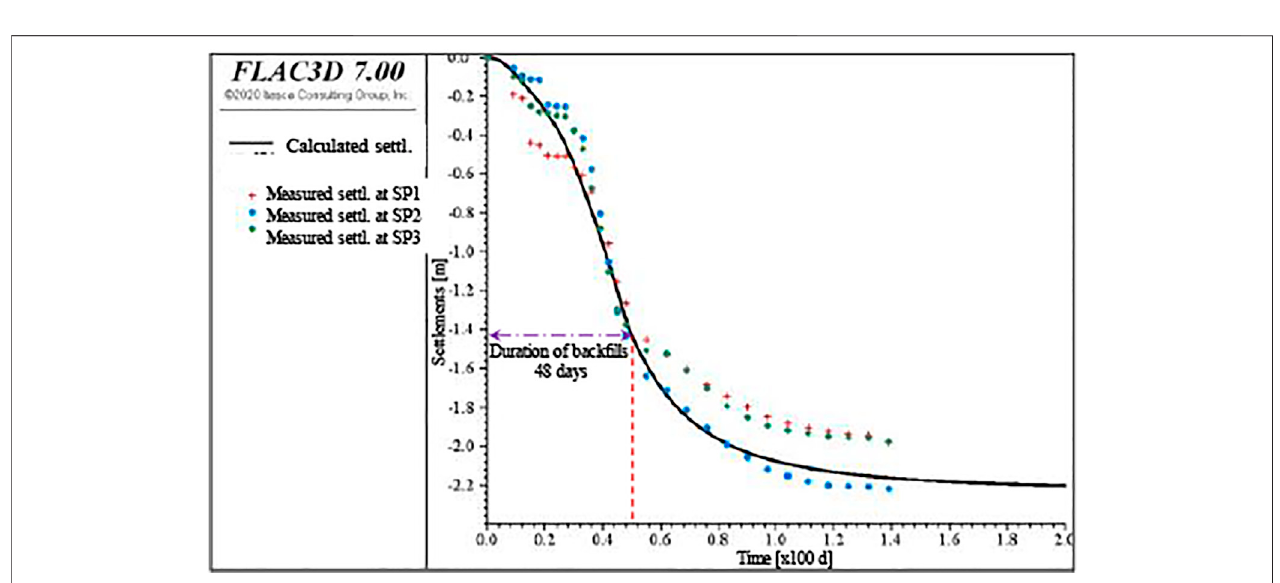
FIGURE 4 | Numerically calculated settlements compared to measured settlements